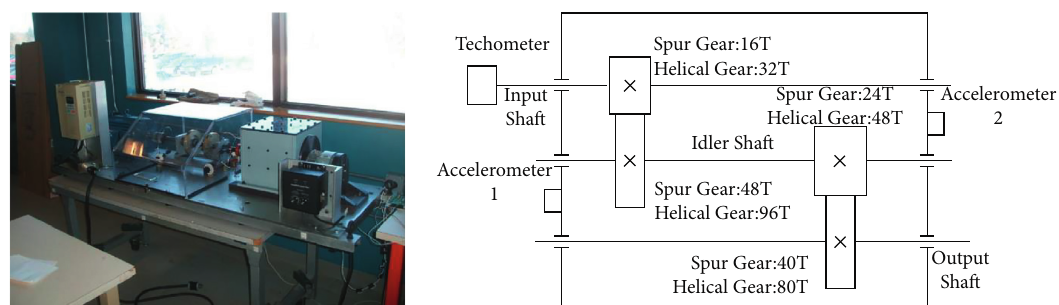
Figure 4: The collection platform’s practicality picture and internal structure abridged drawing.